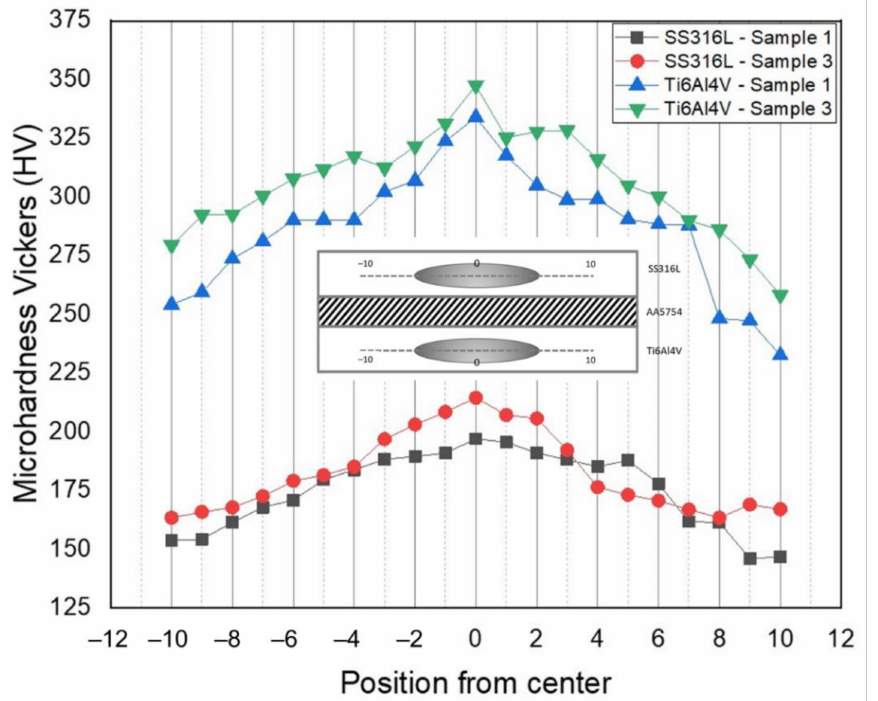
Figure 17. Microhardness Vickers profile from the SS–Ti joint with an aluminum